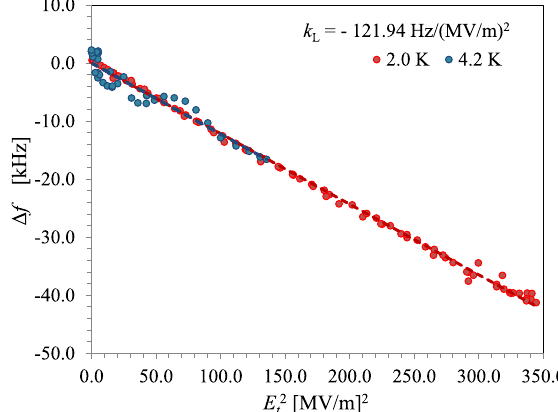
FIG. 13. Lorentz force detuning at 4.2 and 2.0 K rf tests.